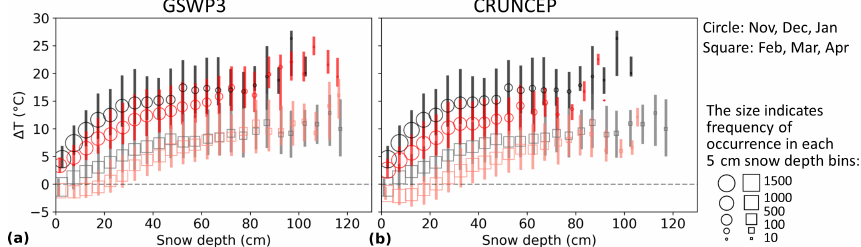
Figure 6. Relationship between (cid:49)T (soil temperature at 20cm depth minus air temperature) and snow depth (cm) over the period 1981–2000, for site-level observations (black), and for model results (red) (9612 site-month values in total), forced by (a) GSWP3 and (b) CRUNCEP. Circles and squares are medians of 5cm snow depth bins, representing the early (November–January) and late (February–April) snow season, respectively. Upper and lower bars indicate the 25th and 75th percentiles of each bin. The size of circles/squares indicates the frequency of occurrence in each